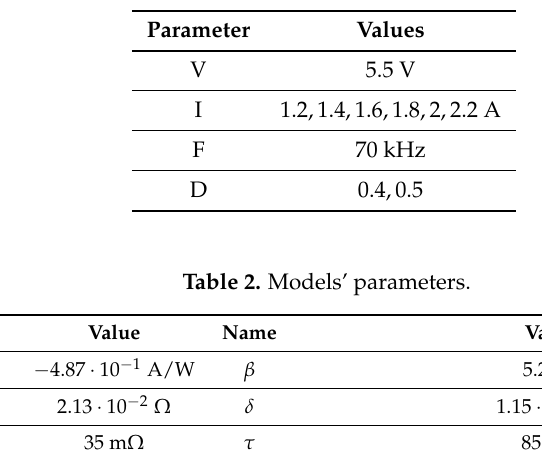
Table 1. Operating conditions used for training the models.